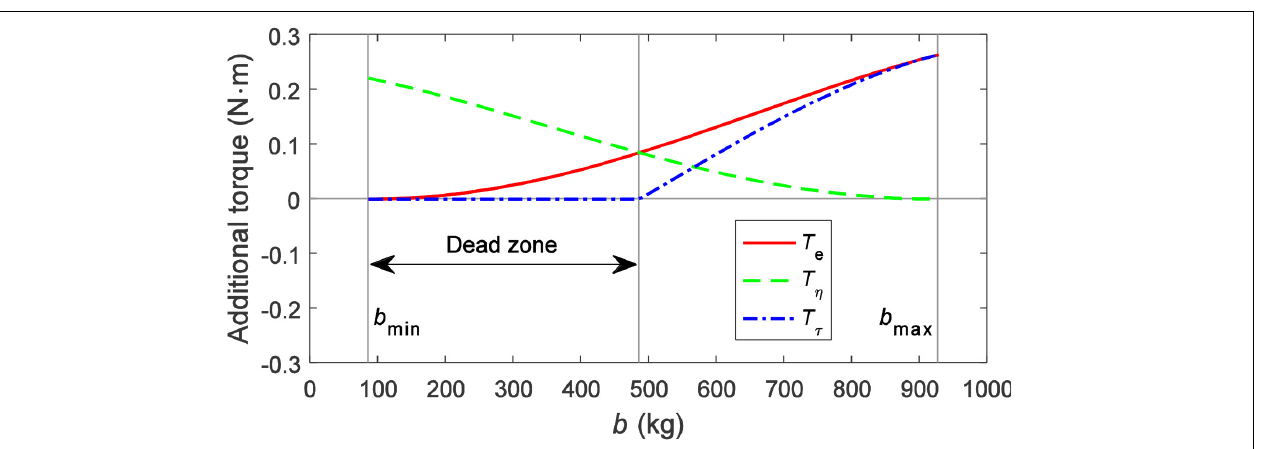
FIGURE 7 | Additional torque during the adjustment of the